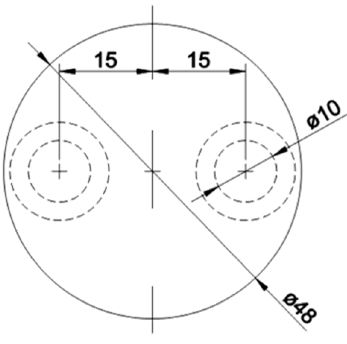
Figure 9. Specimen extraction sketch of bolt steel specimens. Dimensions in mm.